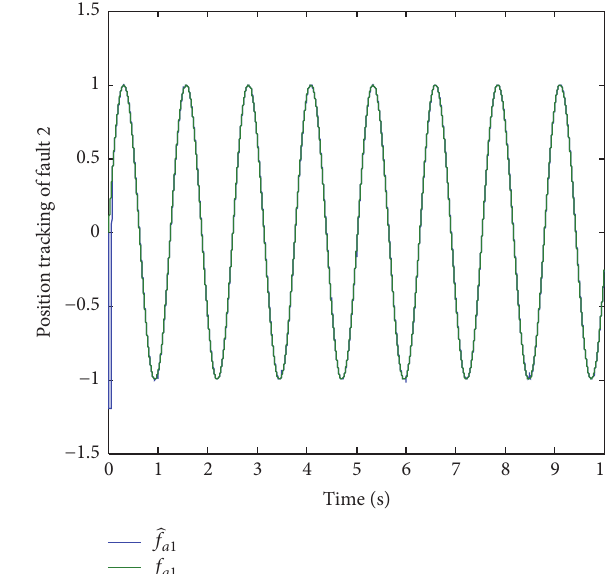
Figure 11: Unknown input disturbance 𝑑 1 and its estimation value.